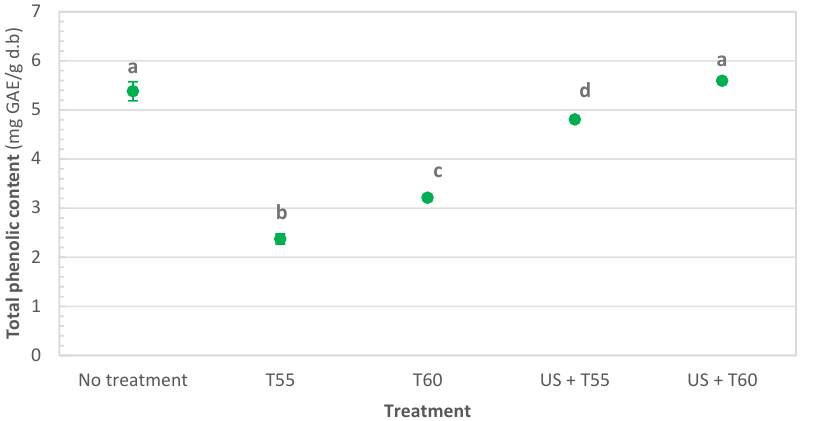
Figure 4. Total phenolic content in untreated, thermally treated, and thermosonicated kiwi peel). Values with different letters differ significantly ( p < 0.01 ).